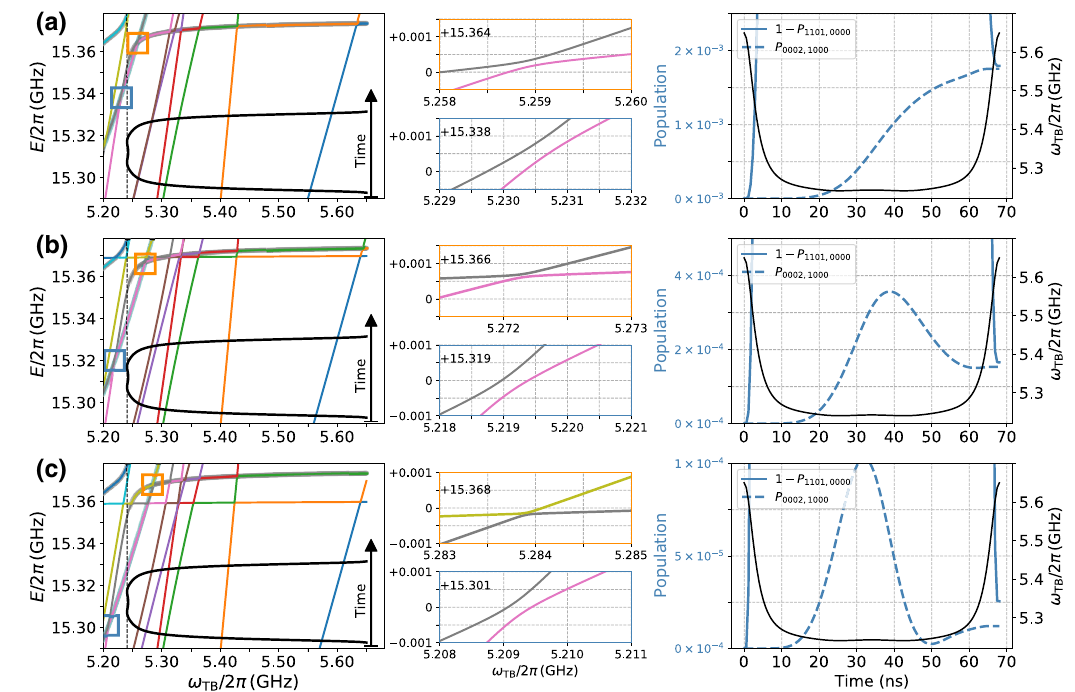
FIG. 9. (Left panel) Energy-level spectrum of the four-qubit square system shown in Fig. 5. The dashed black line indicates the working point, and the orange (steel-blue) square marks the avoided crossing resulting from interaction | 1101, 0000 (cid:2) ↔ | 0002, 1000 (cid:2) and | 0001, 2000 (cid:2) ↔ | 0002, 1000 (cid:2) , respectively, which are highlighted in the middle panel. (Right panel) Time evolution of state population during the implementation of CZ 01 with system prepared in the state | 1101, 0000 (cid:2) . P 1101,0000 and P 0002,1000 denote the population on state | 1101, 0000 (cid:2) and state | 0002, 1000 (cid:2) . The black curves in the left panel and the right panel represent the 68-ns shaped pulse used to realize CZ 01 . (a) Qubit anharmonicities are η Q / 2 π = − 300 MHz. (b) Qubit anharmonicities are η Q / 2 π = − 310 MHz. (c) Qubit anharmonicities are η Q / 2 π = − 320 MHz. Other parameters are the same as in Fig.